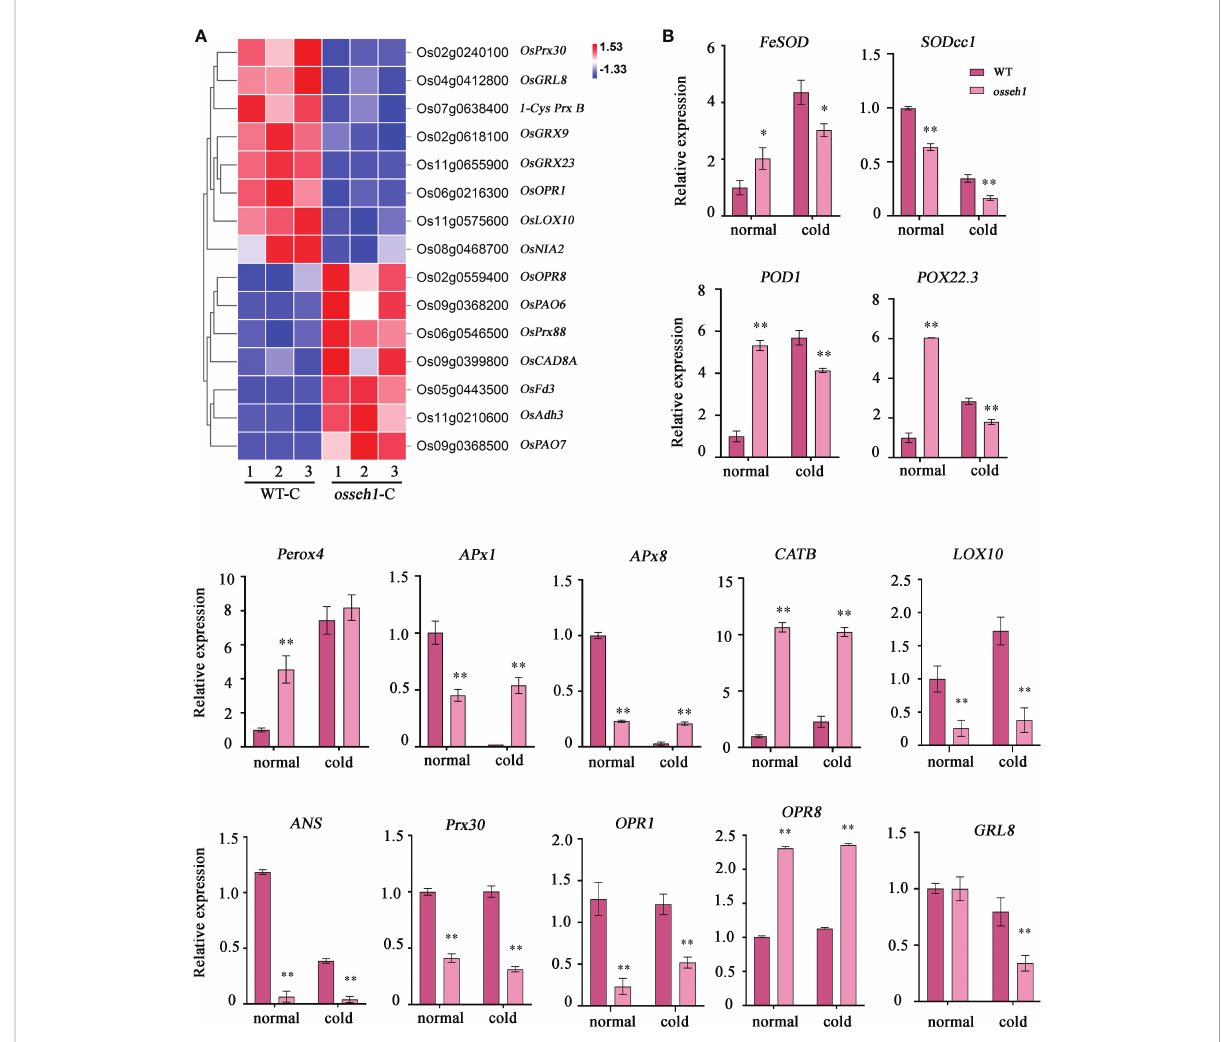
FIGURE 5 DEGs between osseh1 knock-out lines and WT plants were involved in oxidation-reduction process. (A) Heatmap showing the enriched genes in the term of oxidation-reduction process. (B) Transcript levels of genes related to ROS scavenging in osseh1 knock-out lines and WT plants under normal condition and cold stress. Data represents means ± SEM (n = 3). *P < 0.05, **P < 0.01. WT-C, WT under cold treatment. osseh1 - C, osseh1 lines under cold